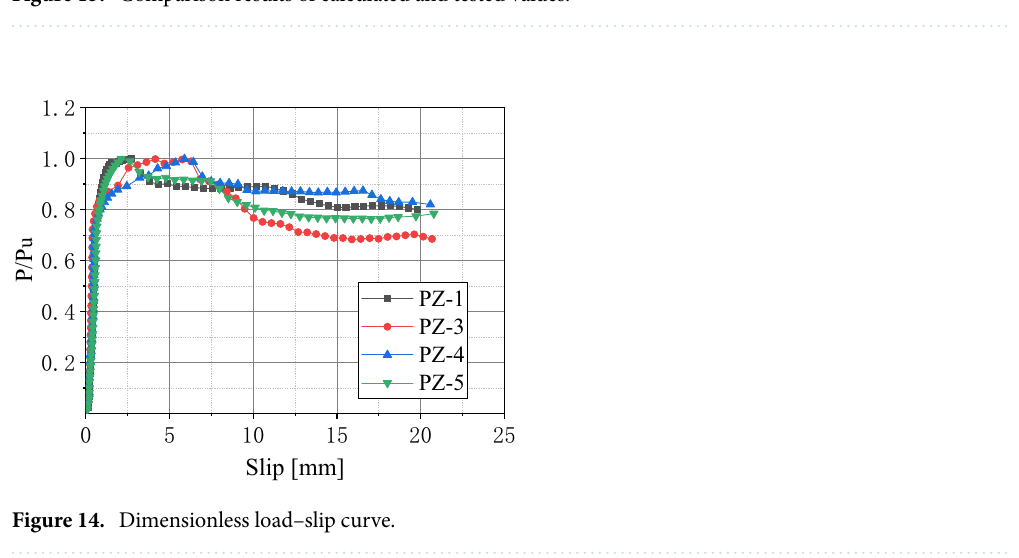
Figure 13. Comparison results of calculated and tested values.